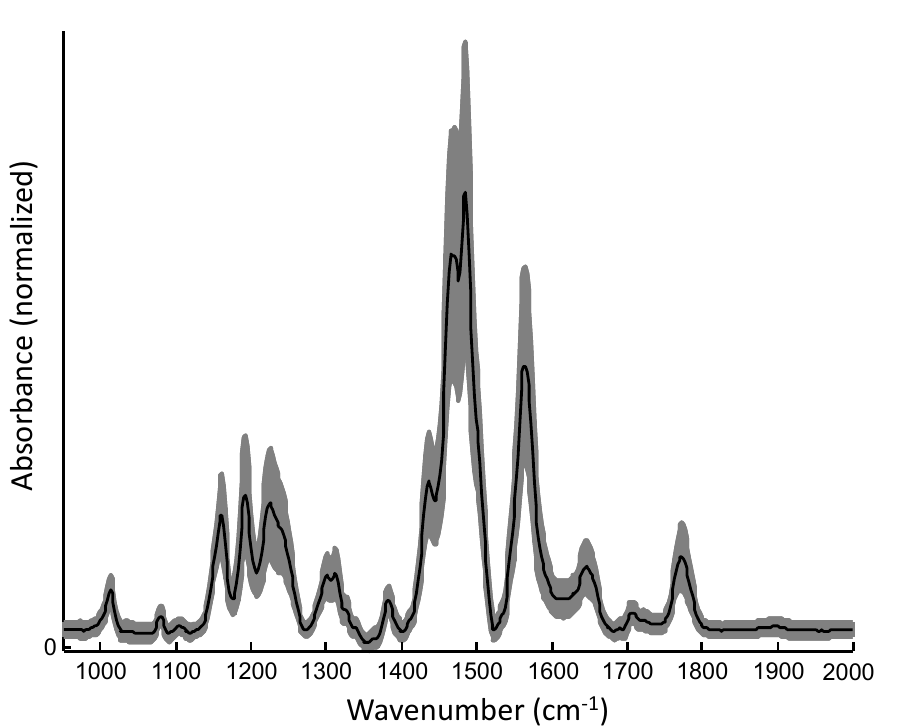
Figure 11. Mean spectrum (black) and standard deviation (gray) calculated from the data set of selected spectra.